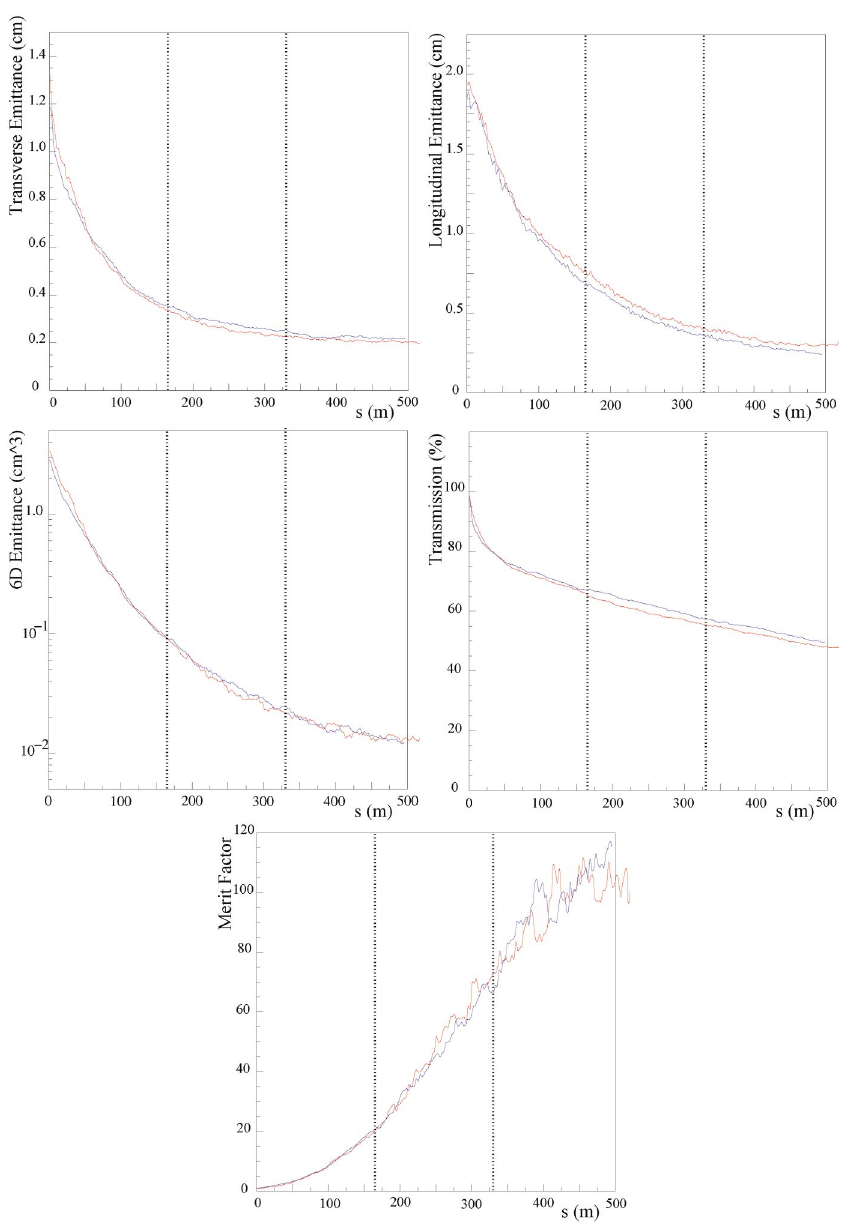
FIG. 13. (Color) A comparison between GEANT (red line) and ICOOL (blue) for: (top panel) transverse emittance and longitudinal emittance; (middle panel) 6D emittance and transmission; (lower panel) M factor vs path length. The vertical lines indicate 5 and 10 ring turns,